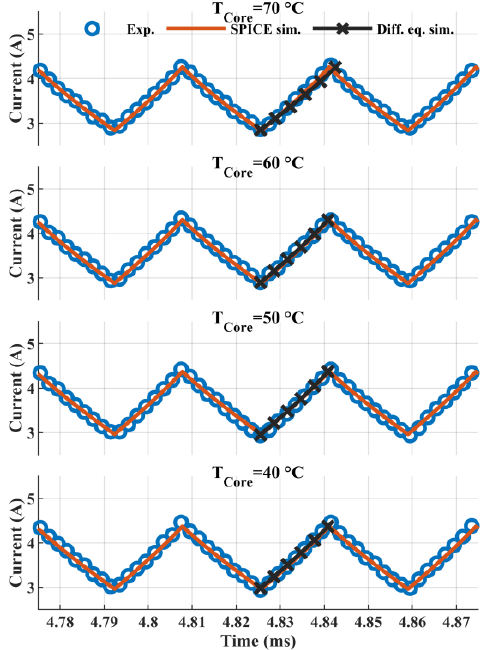
Figure 7. Comparison of the experimental current waveform with the simulation results from SPICE and the differential equation for a duty cycle of 46% at different temperatures.